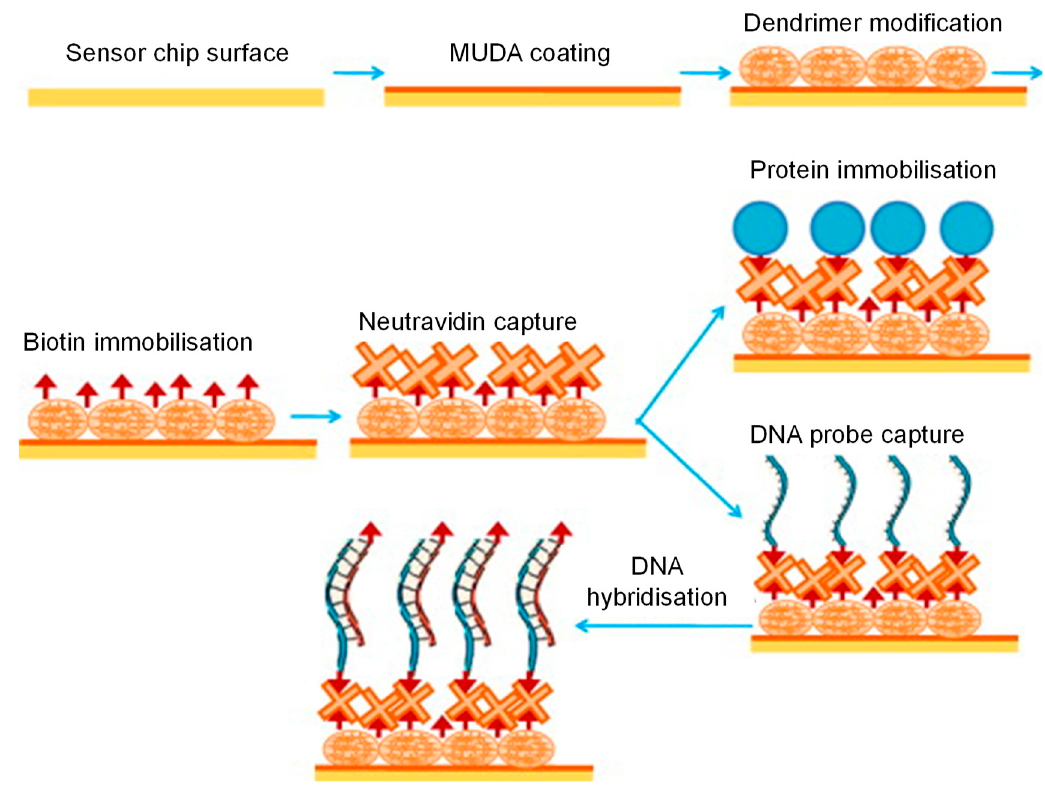
Figure 4. Surface functionalisation of a gold chip for SPR signal enhancement [36]. Reproduced with permission from [36].